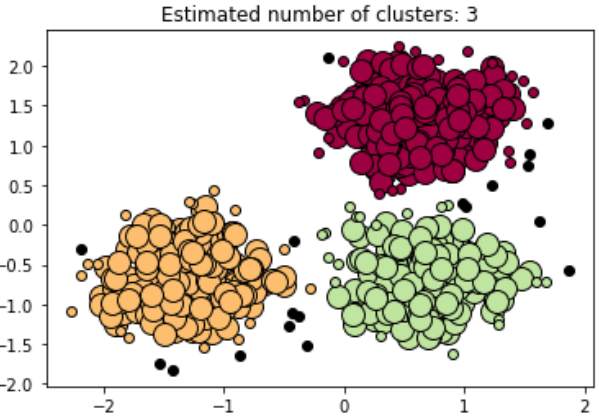
Figure 3. DBSCAN Plot Example with 3 Dense Clusters (After [22]).